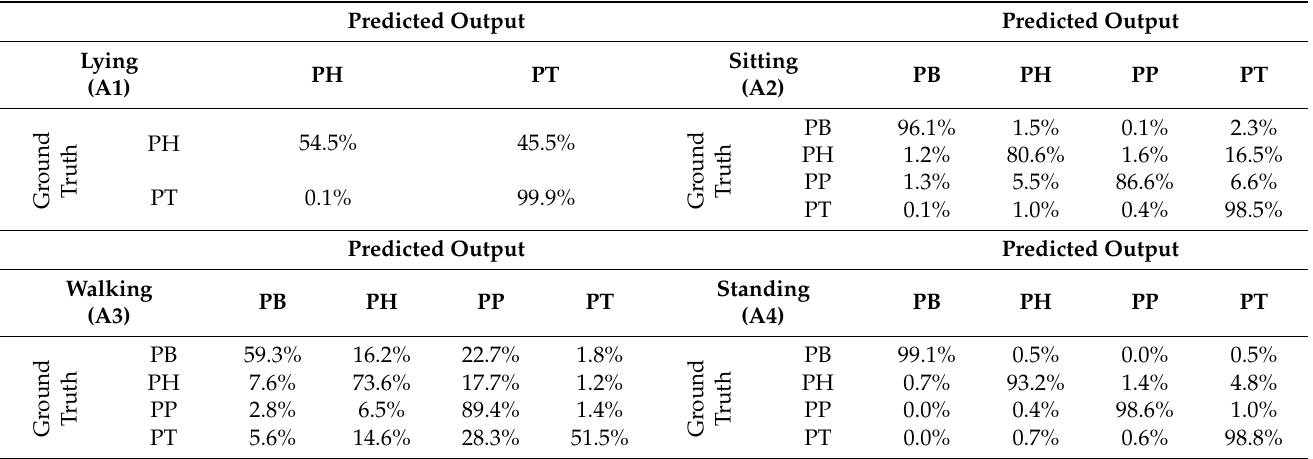
Table 8. Confusion matrices obtained for PCR based on four individual physical activities using BDT